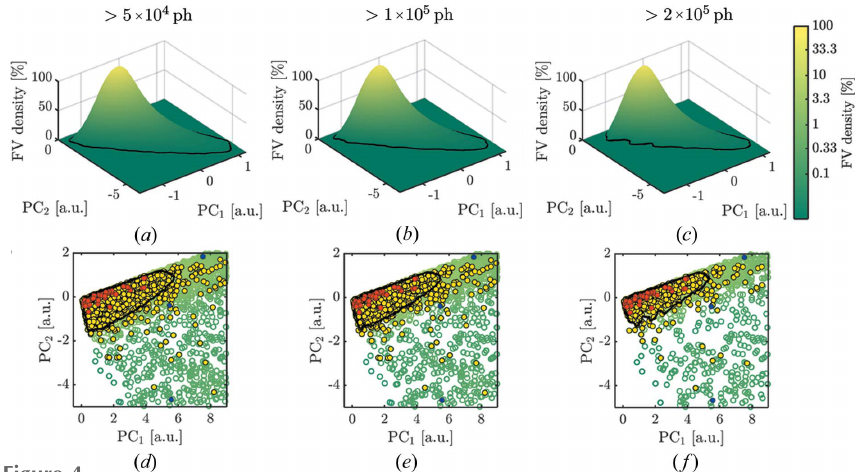
Figure 4 ( a )–( c ) FV densities on PCA planes for different intensity thresholds (number of hits in Table 1). ( d )–( f ) Projection view of the PCA densities with manually classified single-hit patterns shown as red dots. Blue and yellow dots correspond to the same selections as in Fig. 3. The black contour level corresponds to 3.3% of the maximum value of the PCA density (selected hits in Table 1). For low- intensity thresholds, the black contour contains a region that is not clearly represented by the manual single hit selection ( a ), ( d ) and ( b ), ( e ). The manual hit selection is most precisely matched by data Set 10kPCA within the contour line for an intensity threshold at 2 (cid:2) 10 5 ph in ( c ) and ( f ).